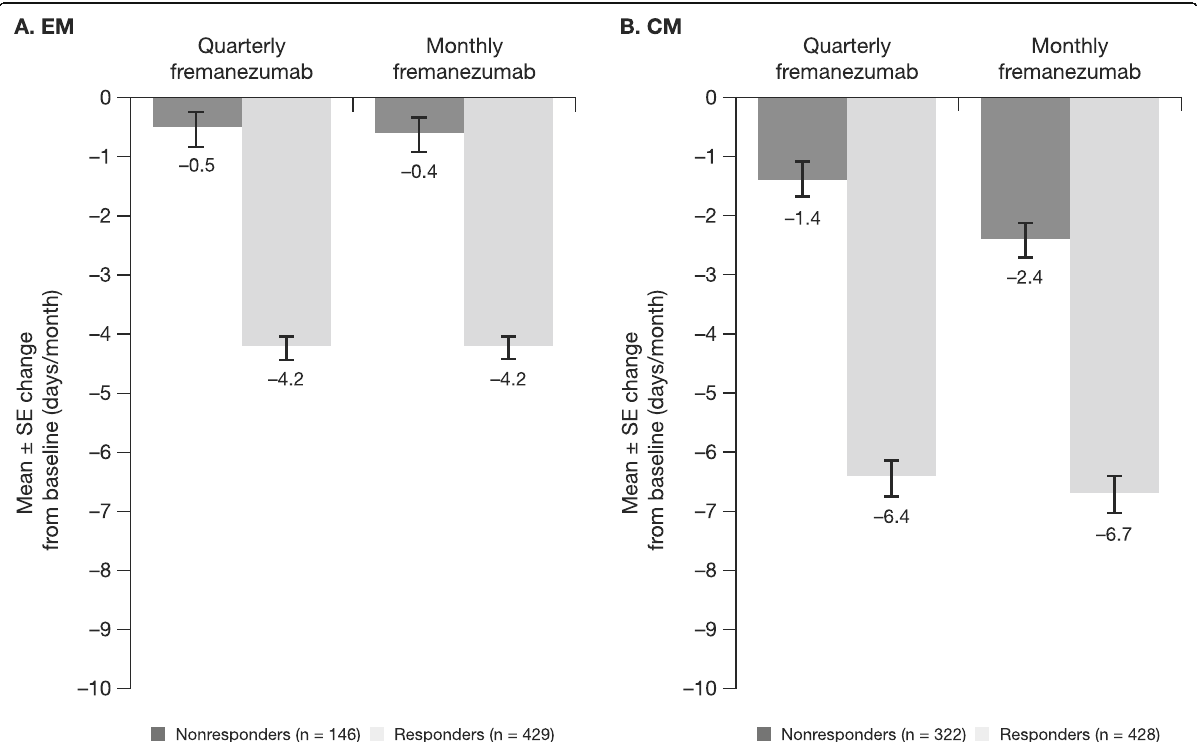
Fig. 4 Mean change from baseline in monthly average number of days with any acute headache medication use. a, b CM, chronic migraine; EM, episodic migraine; MAMD, monthly average migraine days. a For participants with EM, response was defined as a reduction of ≥ 2 MAMD. b For participants with CM, response was defined as a reduction of ≥ 4